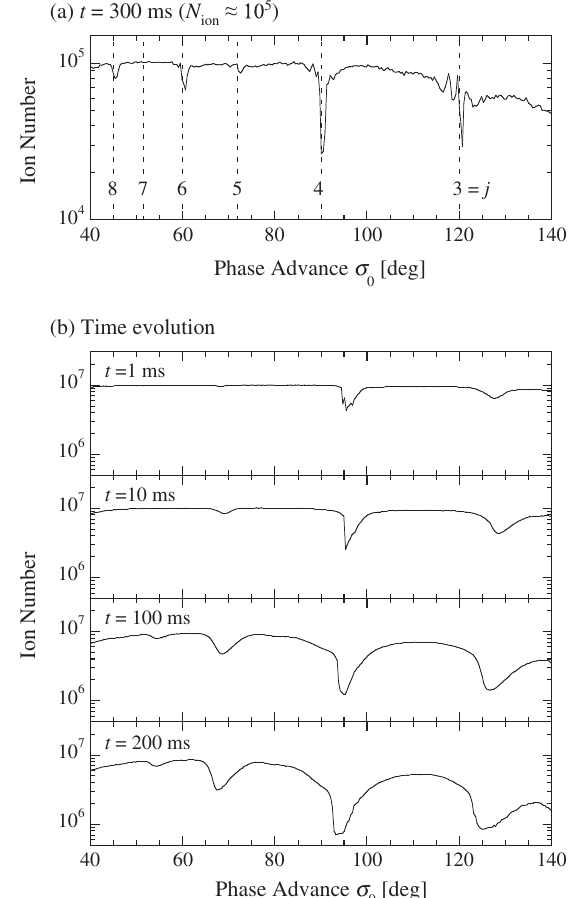
FIG. 14. Long-term stability of a non-neutral plasma confined in S-POD by the sinusoidal focusing potential. (a) Stop-band ≈ 10 5 . The distribution measured at the initial ion number N ion storage period of ions is fixed at 300 ms corresponding to 3 × 10 5 AG periods. The vertical broken lines indicate the positions of the phase-advance values 360 ° =j ( j ¼ 3 ; 4 ; … ; 8 ). (b) Time-evolution of the stop-band distribution in the space-charge-dominant ≈ 10 7 regime where N ion